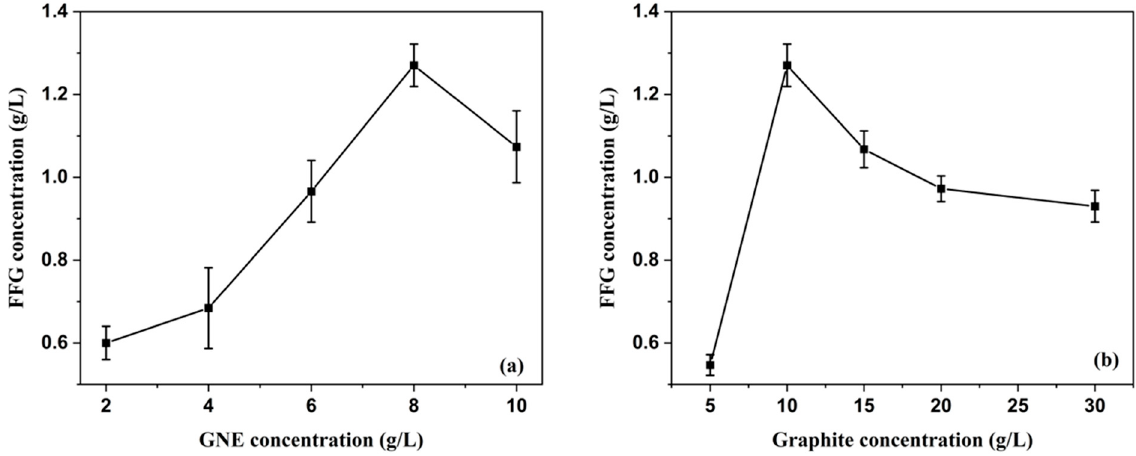
Figure 9. ( a ) Effect of GNE concentration and ( b ) initial graphite concentration on FFG concentration during the exfoliation process.